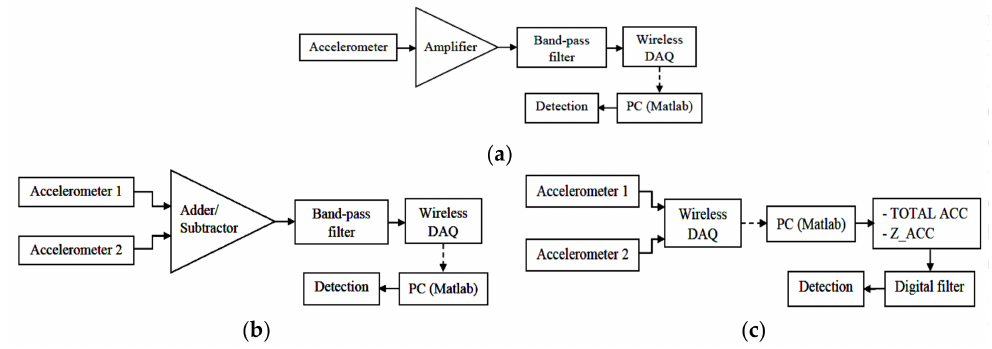
Figure 5. Block diagram ( a ) noise removal using one accelerometer for comparison, ( b ) analog processing steps, and ( c ) digital processing